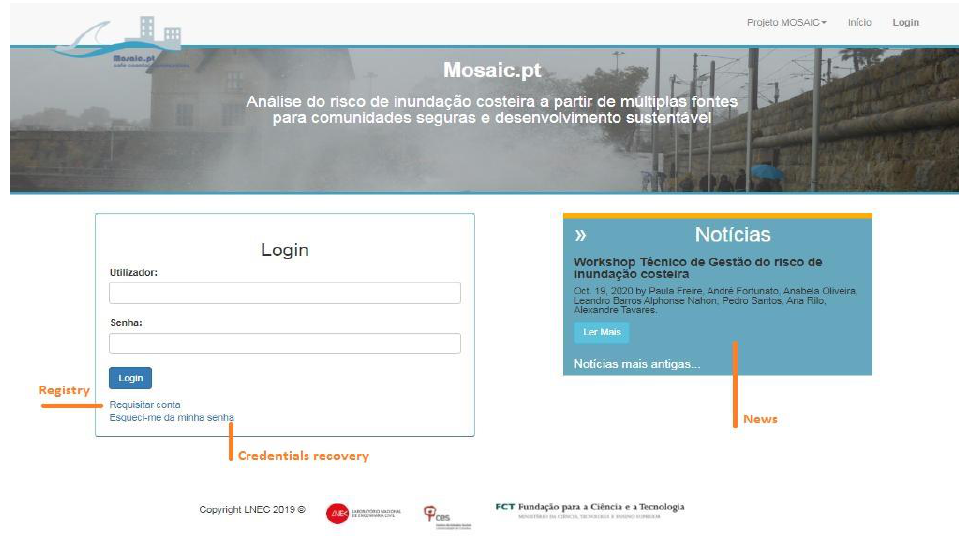
Figure 3. Welcome dashboard of the platform.